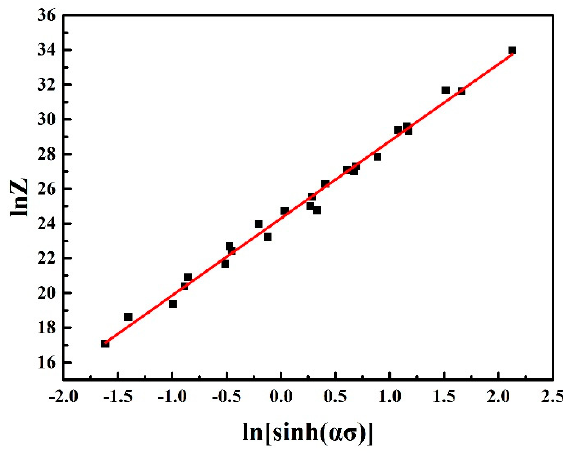
Figure 3. Relationship between ln Z and ln[sinh( ασ )].